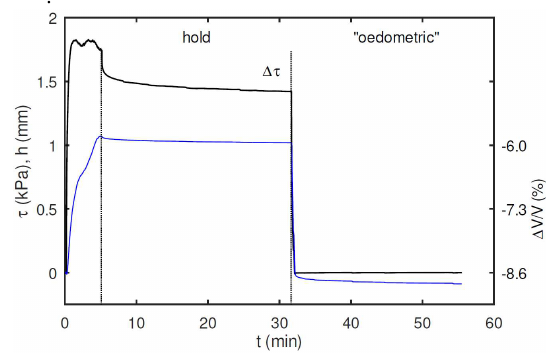
Fig. 1. Shear stress evolution (upper black) and height or relative volume change of the powder bed (lower blue with respectively left or right scale) versus time. Before the holding period, the sample is sheared at constant rotational velocity. After the hold, the shear stress is released to zero. Powder used: coarse torrefied powder (Tor5);  = 1.8 kPa; Big